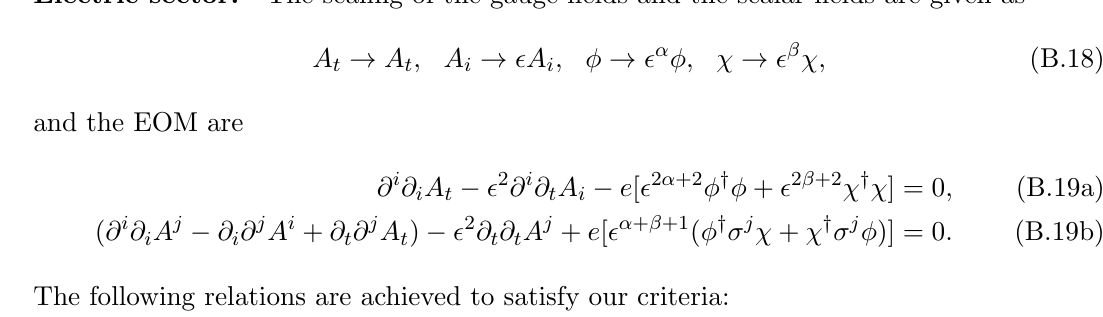
Figure 2. Conditions for scaling of spinor (cid:12)elds in Electric and Magnetic limits. Electric